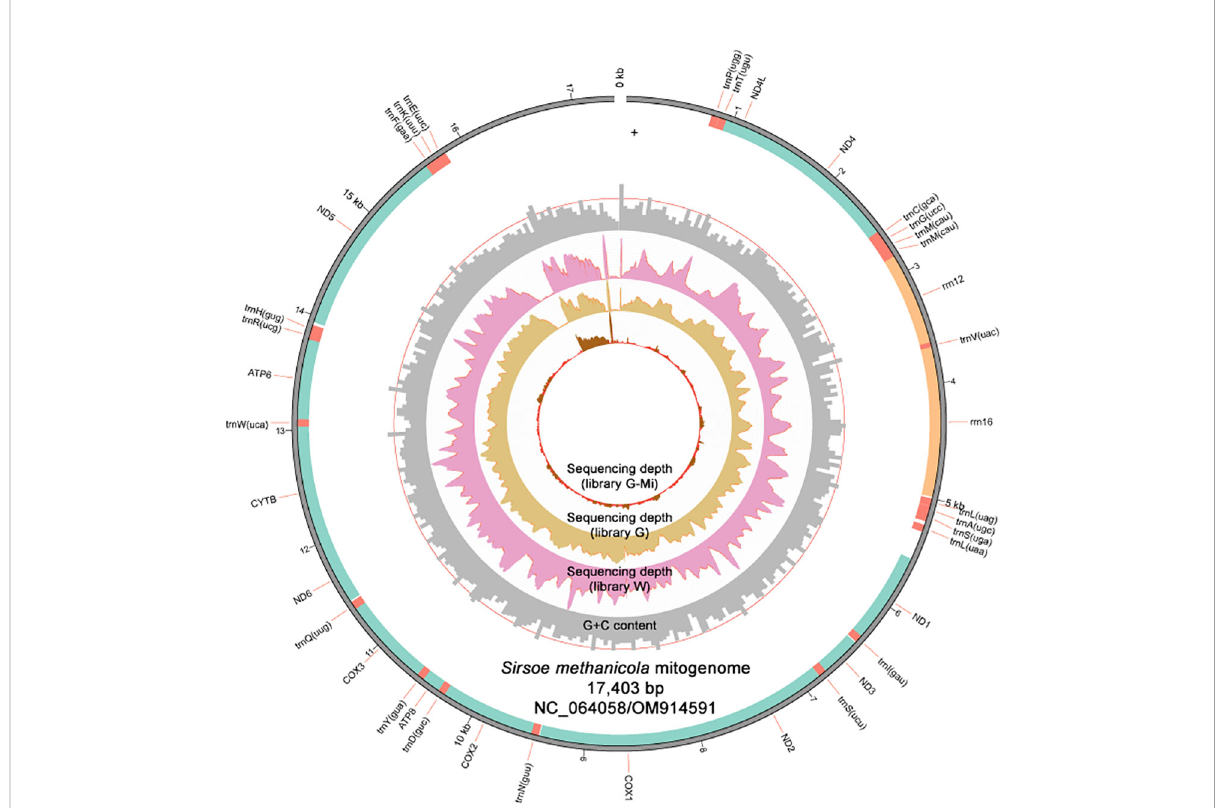
FIGURE 2 Map of the linear 17,403-bp S. methanicola mitogenome (NCBI accessions: NC_064058/OM91459) visualized by Circos implemented in MitoZ. The mitogenome includes protein-coding (green), rRNA (orange), and tRNA (red) gene regions. The red line on the G+C content track marks the G+C content threshold of 50%. The red lines on the depth distribution for library G-Mi indicate regions with sequencing depths lower than